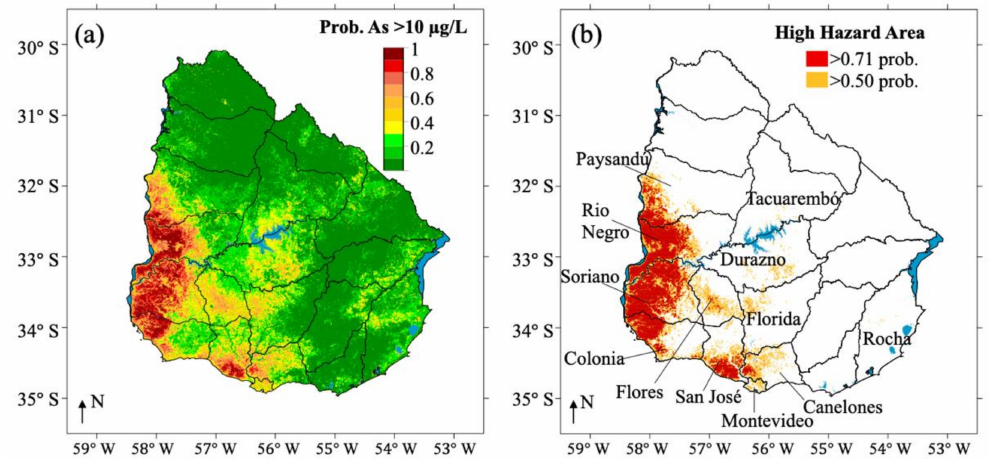
Figure 2. Pure overall model (1A-ML-Pure) of Uruguay groundwater arsenic concentrations: ( a ) map of probability of groundwater arsenic concentrations exceeding 10 µ g/L; ( b ) map of high groundwater arsenic hazard areas (defined here by a probability exceeding cutoff values of 0.50 or